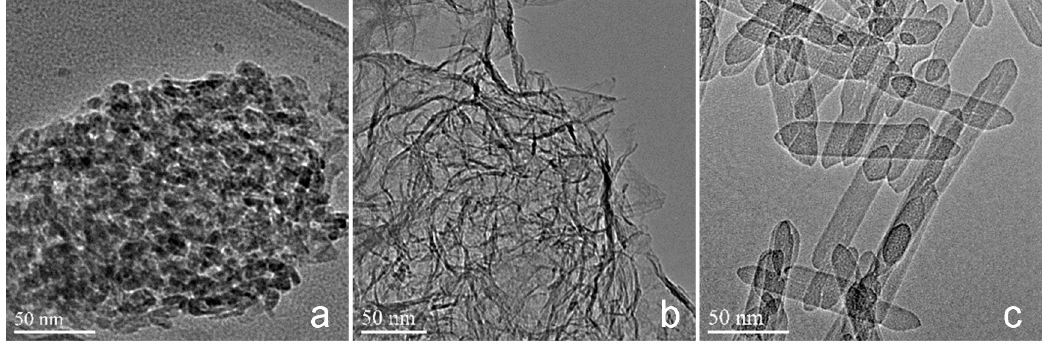
Figure 2. High resolution transmission electron microscope (HRTEM) images of ( a ) SB-500, ( b ) GA-1-500, and ( c ) GA-2-500.